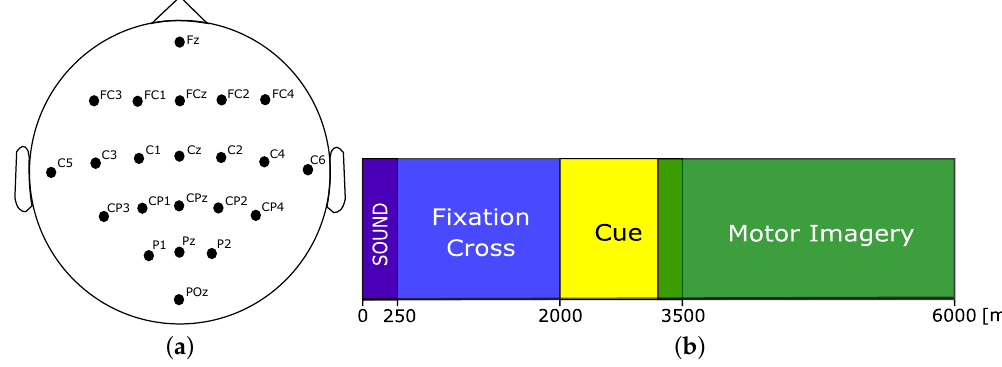
Figure 1. BCI competition IV acquisition setup. ( a ) EEG montage. ( b ) Paradigm time scheme.